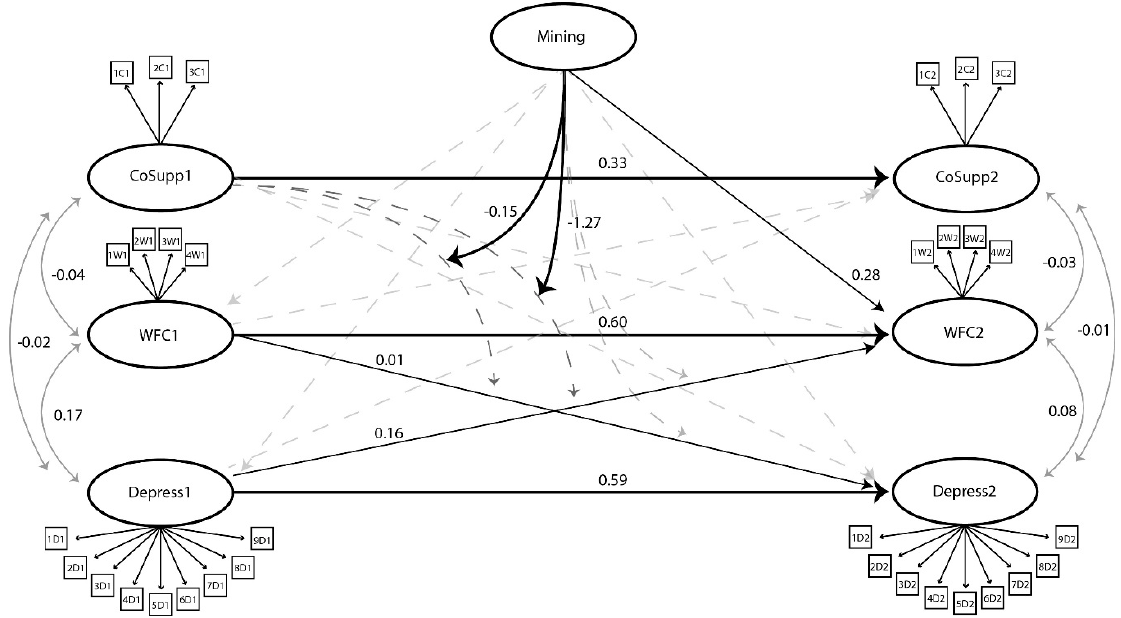
Figure 3. A two wave panel design structural equasion model with two and three-way interaction terms. CoSupp = Co-worker Support. WFC = Work-family Conflict. Depress = Depression. Dashed lines represent non-significant main effects.